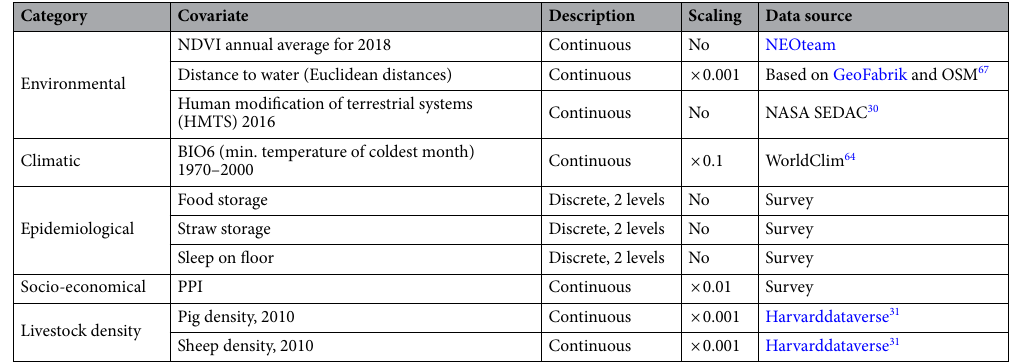
Table 4. Geospatial covariates used for the current estimation of snakebite risk in humans or animals (gridded and survey